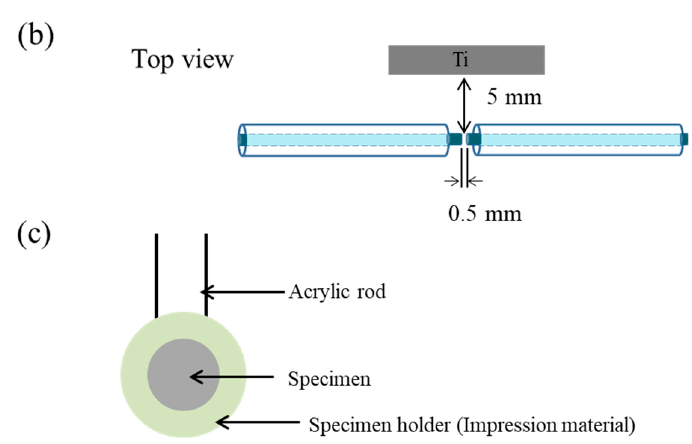
Figure 1. Apparatus, electrodes, and specimen employed for the solution plasma treatment. The specimen was placed at a 5-mm distance from the electrodes in a glass vial containing 150 mL of the mineralizing solution. Plasma was generated at 5 V and 3 µ m pulse width for 30 min. ( a ) Pulse plasma generator, Magnetic stirrer, Holder stand; ( b ) Electrodes (2 electrode having 0.5 mm distance between them; ( c ) The specimen holder is made of Duplicone and acrylic rods help to hold the specimen holder.